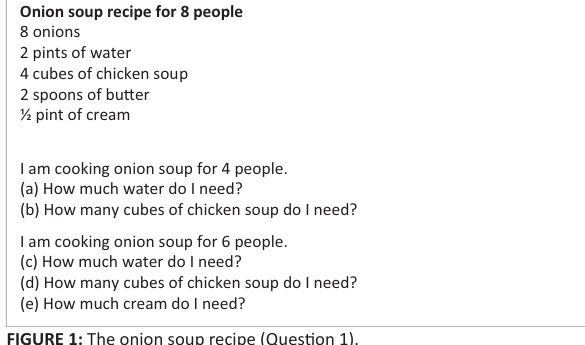
FIGURE 1: The onion soup recipe (Question 1).